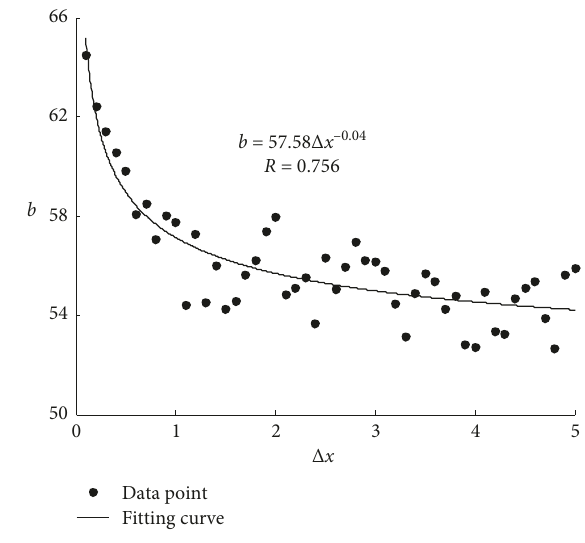
Figure 4: Relationship between b and Δ x .